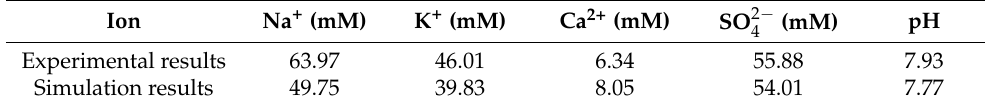
Table 3. Comparison between the experimental and simulation results of the ionic